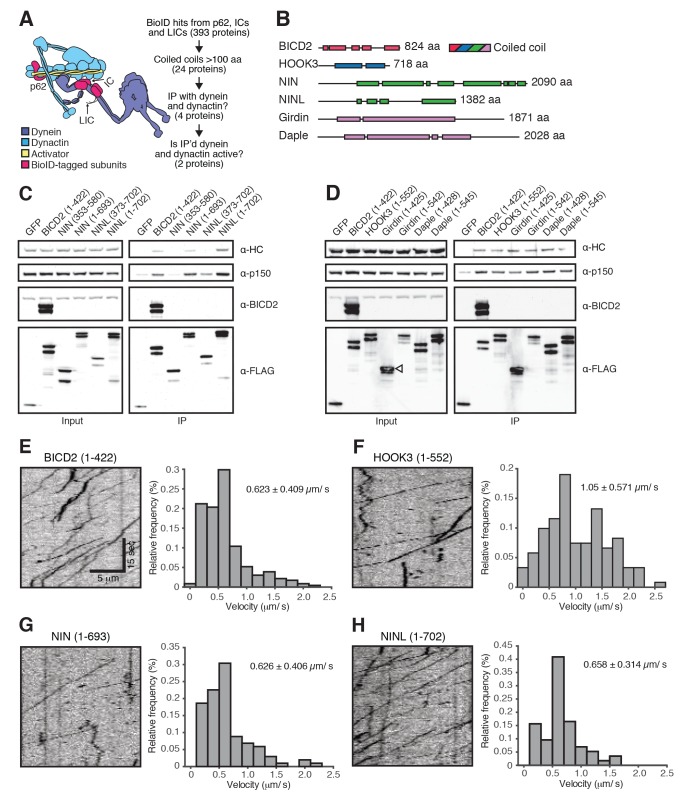
A secondary screen identifies candidate activators of dynein/dynactin motility.(A) A schematic of our secondary screen. (B) Location of predicted coiled coils (rectangles) in known and candidate dynein/dynactin activators. (C, D) Candidate and known (BICD2 and HOOK3) activators tagged with 3×FLAG were immunoprecipitated with α-FLAG antibodies from HEK-293 cells. Western blots with α-HC and α-p150 antibodies were used to determine which proteins co-immunoprecipitated dynein and dynactin. (E—H) The candidate NIN (1-693) and NINL (1-702) activators, as well as the known BICD2 (1–422) and HOOK3 (1–552) activators were tagged with GFP and 3×FLAG and were immunoprecipitated with α-FLAG antibodies from HEK-293 cells. The motility of immunoprecipitated dynein/dynactin/activator complexes was monitored by GFP fluorescence using TIRF microscopy. Kymographs (left) and velocity histograms (right) with mean velocity (± S.D.) shown, n is greater than 102. Data shown is analyzed from one technical replicate, although two technical replicates were collected for each activator and displayed similar trends.